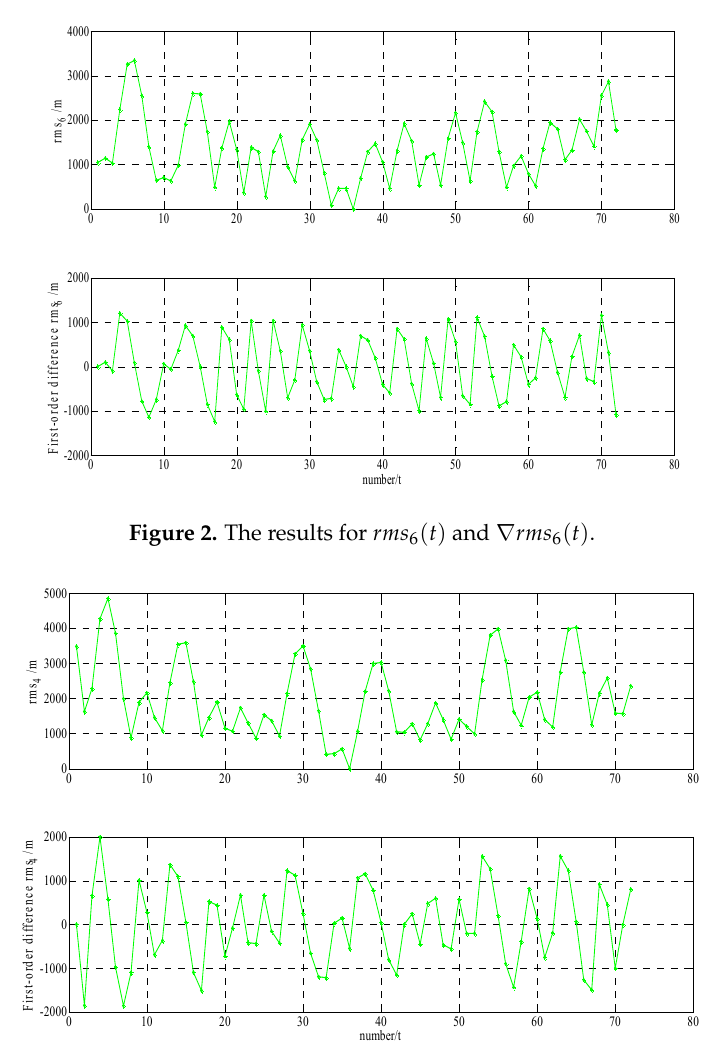
Figure 3. The results for rms 4 ( t ) and ∇ rms 4 ( t ) .